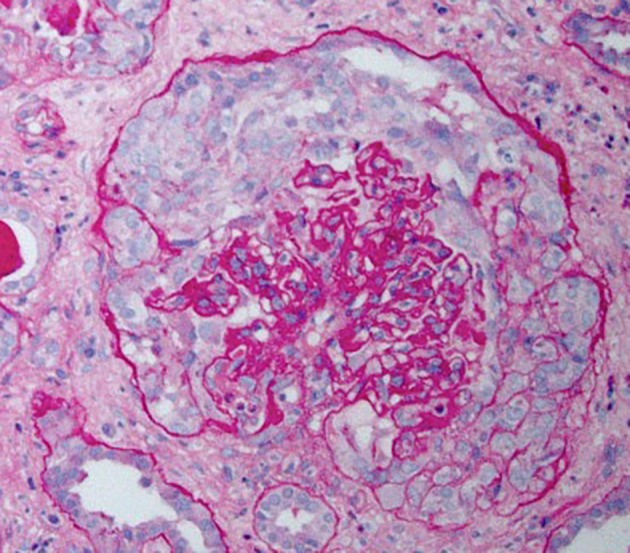
Periodic acid–Schiff stained kidney biopsy from a patient with HIVAN demonstrating collapsed glomerulus with focal global sclerosis and overlying pseudocrescent composed of proliferating glomerular epithelial cells. There is also prominent tubular atrophy and interstitial fibrosis.